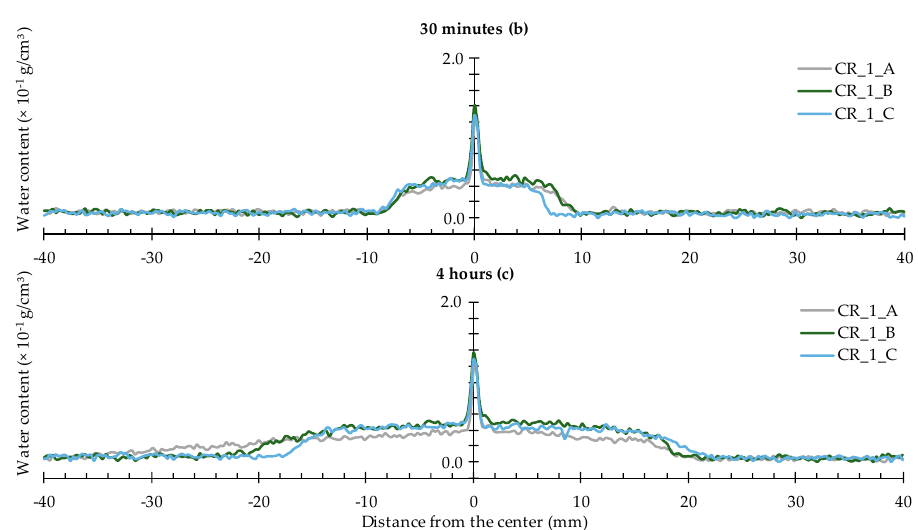
Figure 10. Water profiles of the three standard mortar prisms containing one artificial crack: ( a ) after 5 min; ( b ) after 30 min; and ( c ) after 4 h.